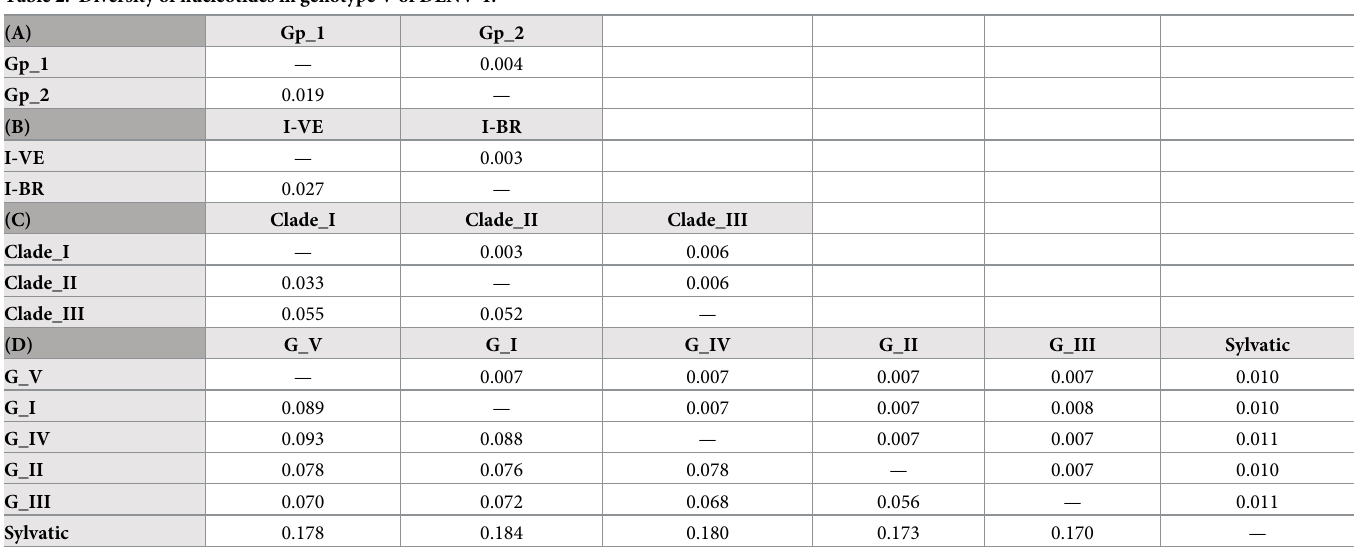
Table 2. Diversity of nucleotides in genotype V of DENV-1.